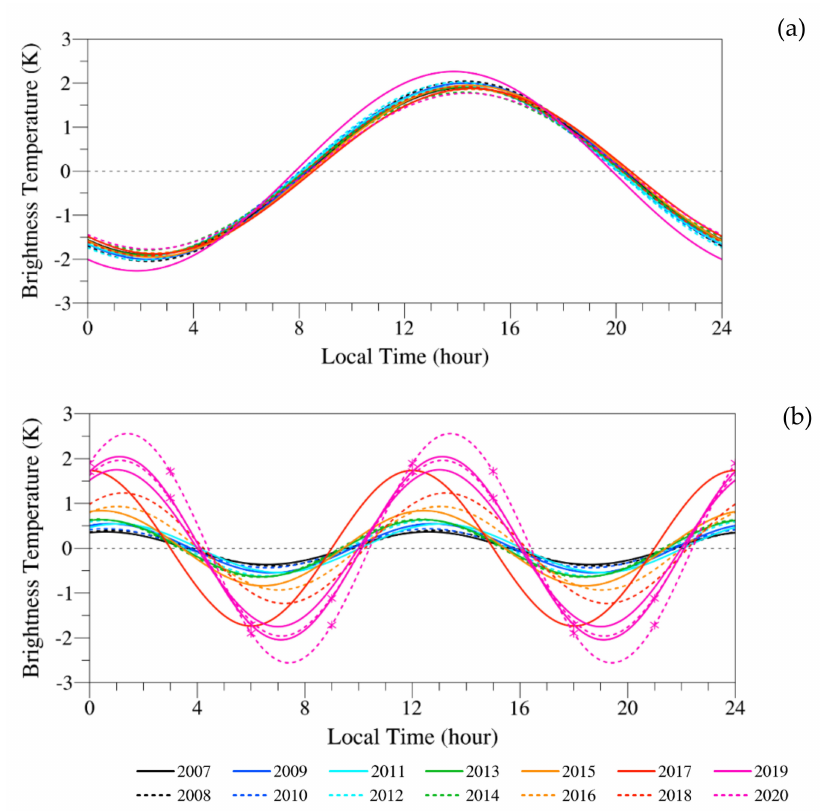
Figure 8. Decadal changes of ( a ) the diurnal component and ( b ) the semi-diurnal component of AMSU-A channel-3 brightness temperature observations in spring from 2007 to 2020. The curves with stars mean the diurnal variations derived without FY-3D MWTS-2.